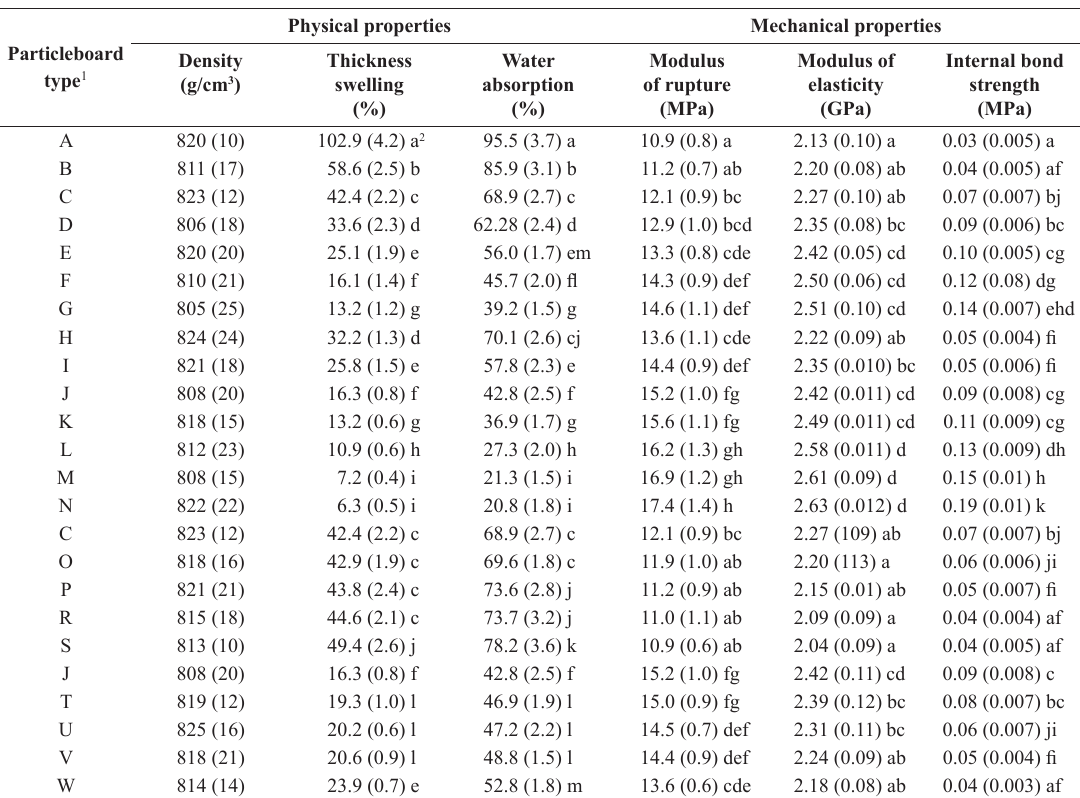
Table 2. Physical and mechanical properties of the